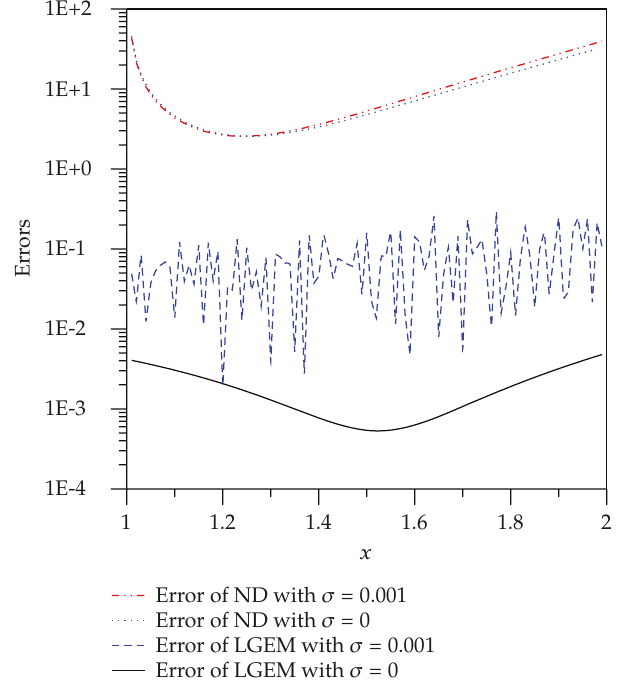
Figure 6: Example 6.6 comparing the estimation errors of p (cid:6) x (cid:7) under random disturbances with σ (cid:9) 0 and σ (cid:9)